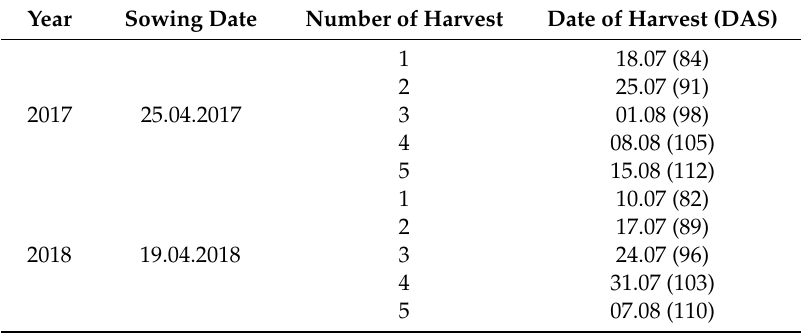
Table 2. Sowing dates and the number and date of harvests (days after sowing (DAS)) in the experimental years 2017 and 2018. Year Sowing Date Number of Harvest Date of Harvest